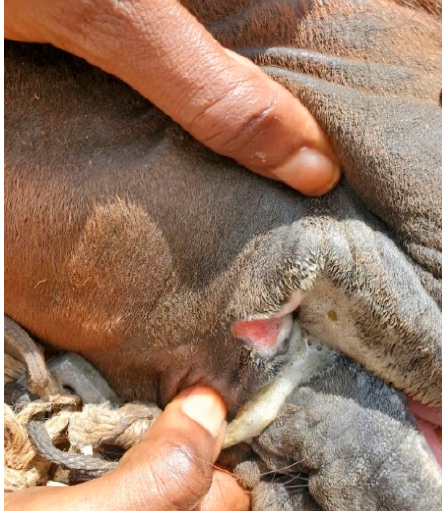
Figure 1. Bit ‐ related lip lesion on a cart horse in Senegal; seemingly caused by bit mouth ‐ piece.